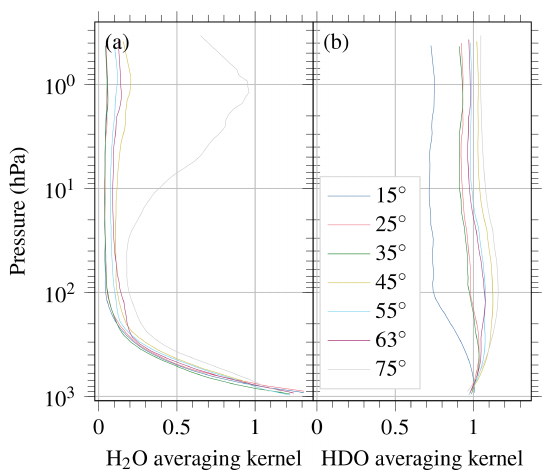
Figure 2. Examples of column averaging kernels for (a) H 2 O and (b) HDO for different solar zenith angles in orbit 4924 on 25 September 2018.